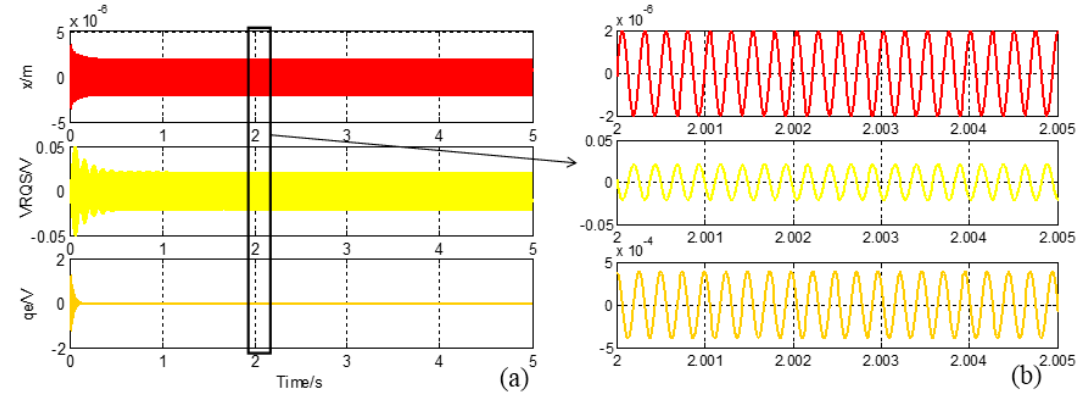
Figure 8. ( a ) Right-mass CIC system simulation curves; ( b ) Enlarged curves of right-mass CIC system simulation result.